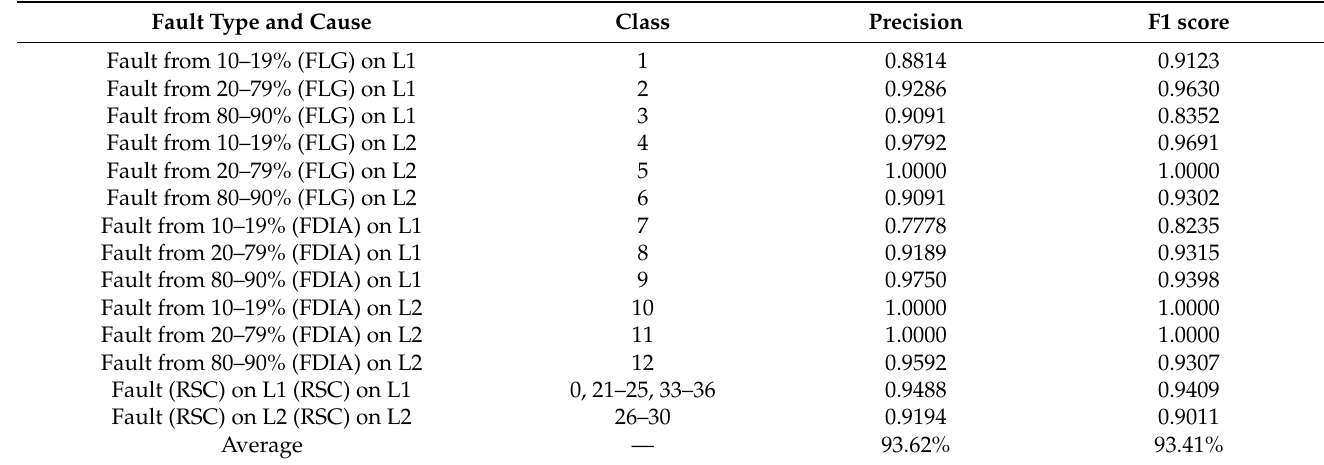
Table 4. Analysis of fault detection performance.